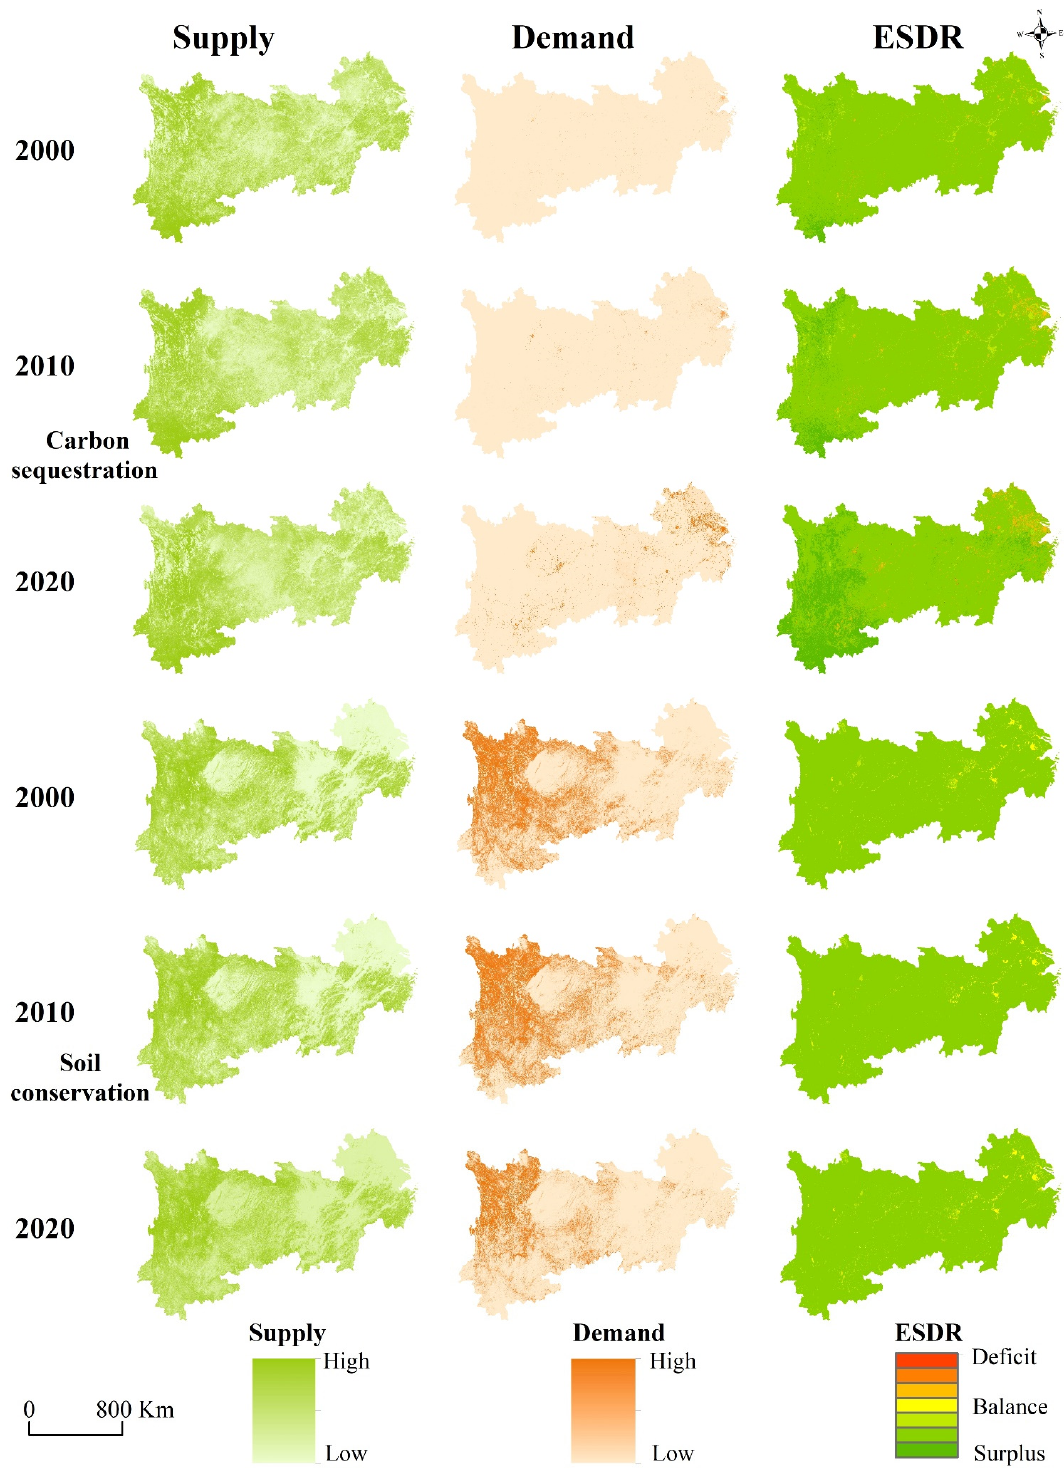
Figure 3. Spatial distribution of supply (left column), demand (middle column), and ESDR (right column) for carbon sequestration and soil conservation in the YREB from 2000 to